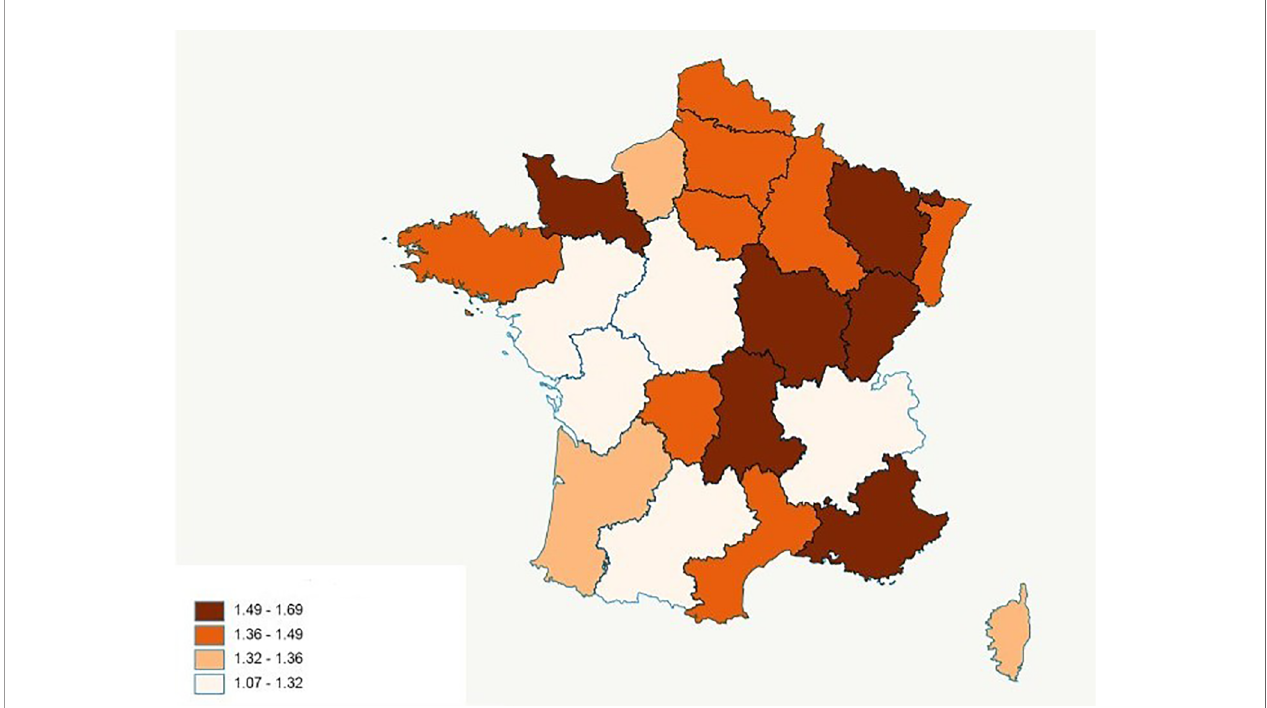
FIGURE 4 | Distribution of the population of incident Chronic Myeloid Leukemia (CML) patient identi fi ed in the SNDS between 2011 and 2014 by regions of France. These are estimates of CML incidence per 100,000 inhabitants. Regions are those in which incident CML patients lived in